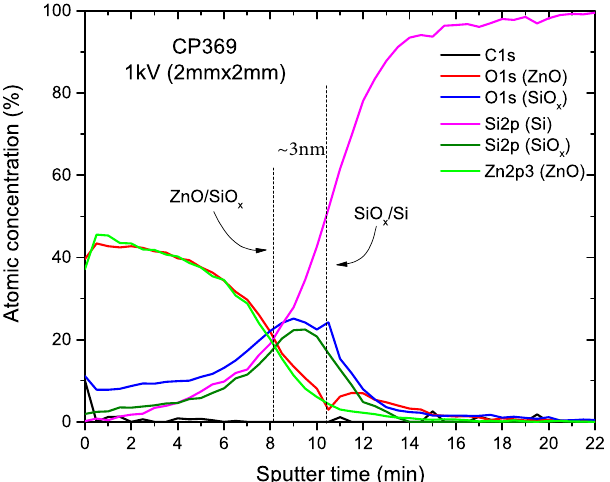
Fig. 3. XPS depth profiles of Zn, O and Si, as a function of sputtering time. We have decomposed the O related to Si and the O related to Zn. We have done the same for Si.